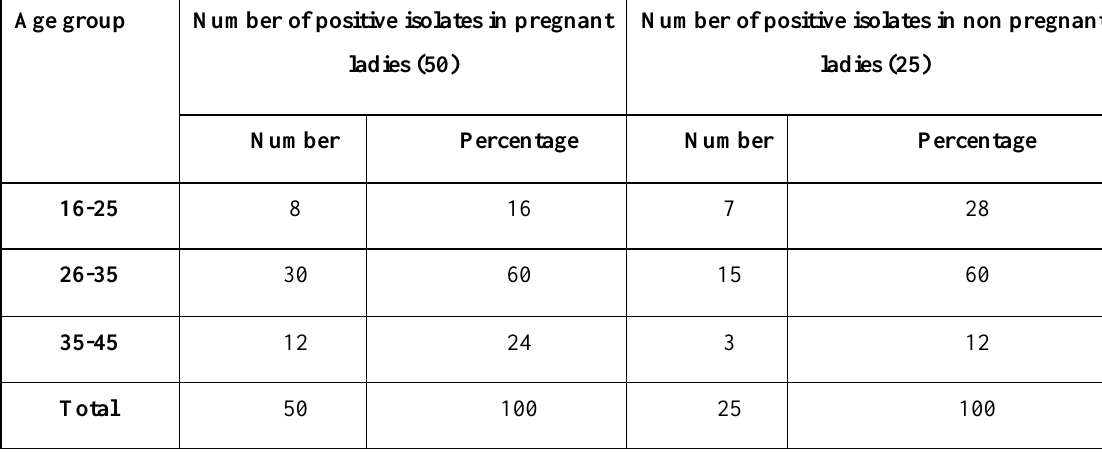
Table 2. Percentage of isolated Candida among age